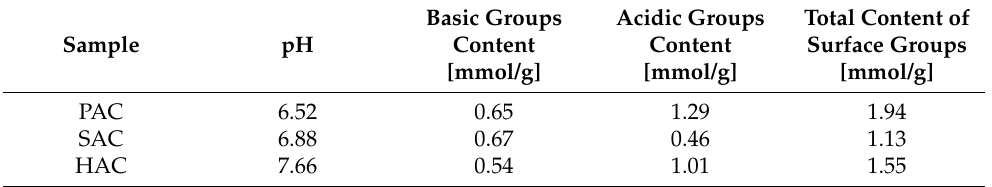
Table 2. Acidic-basic properties of the activated biocarbons